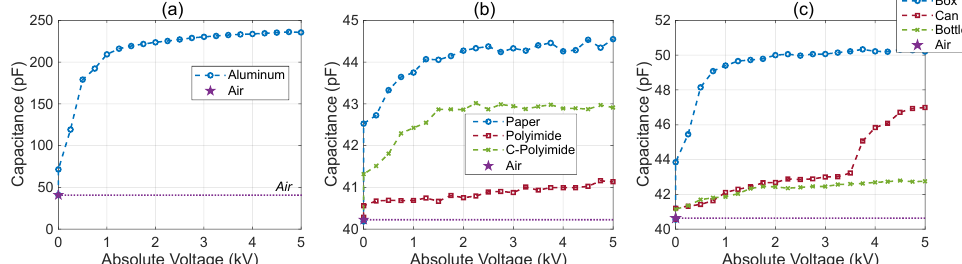
Figure 6. Electroadhesive pad voltage–capacitance characteristic with different substrate materials and suspended in air (no voltage applied). ( a ) V-C dependence of the pad in contact with a polished aluminum plate; ( b ) V-C dependence in contact with three films: a standard A4 recycled sheet of paper; a 25 µ m sheet of polyimide; and a 25 µ m sheet of polyimide loaded with carbon particles. ( c ) Voltage–capacitance (V-C) dependence of the pad in contact with three common packaging objects: a laminated rectangular cardboard box; a steel cylindrical can covered in a painted paper label; and a colored high-density polyethylene (HDPE) bottle, partially covered with a colored paper